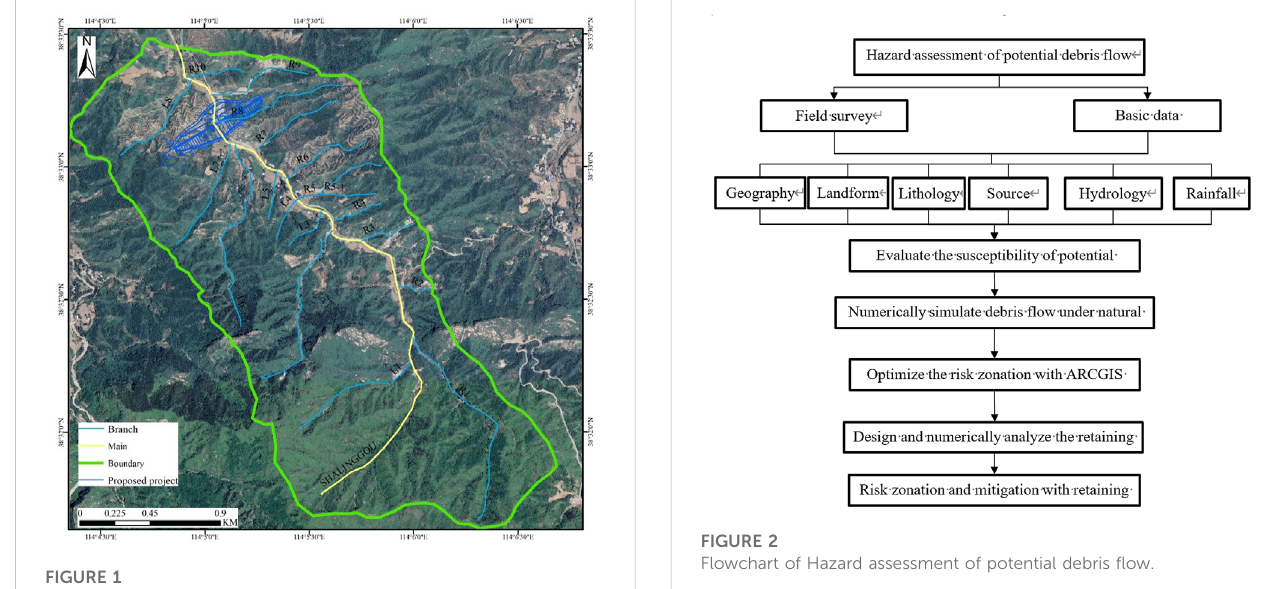
FIGURE 1 Drainage pattern of potential debris fl ow and location of engineering structures in Shaling Gully.